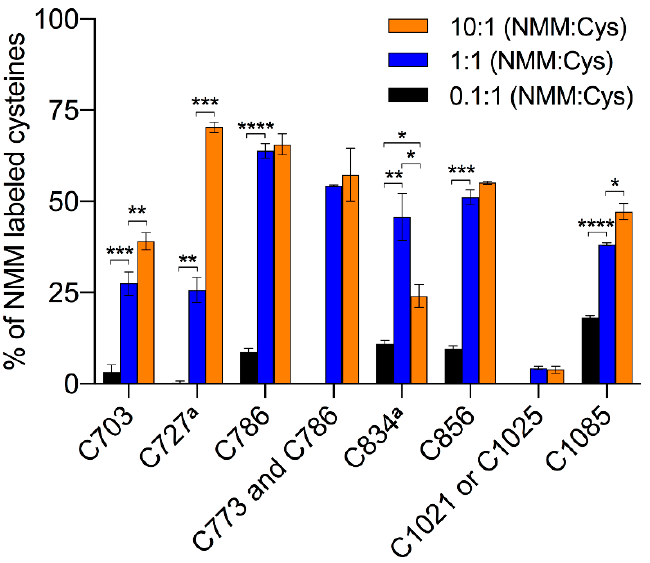
Figure 4. Mapping of binding sites for the electrophilic activator N-methylmaleimide (NMM) in human TRPA1 (hTRPA1). The bar chart shows percent site labeling of NMM. The experiments were conducted in triplicates at each concentration of NMM under a fixed reaction time. The percentage of labeling is presented as the mean with standard deviation. * p < 0.05, ** p < 0.01, and **** p < 0.0001 indicate that differences in labeling of cysteine at different concentrations of NMM are statistically significant using unpaired t-test with Welch’s correction. ᵃ Data is retrieved from the chymotrypsin digestion.